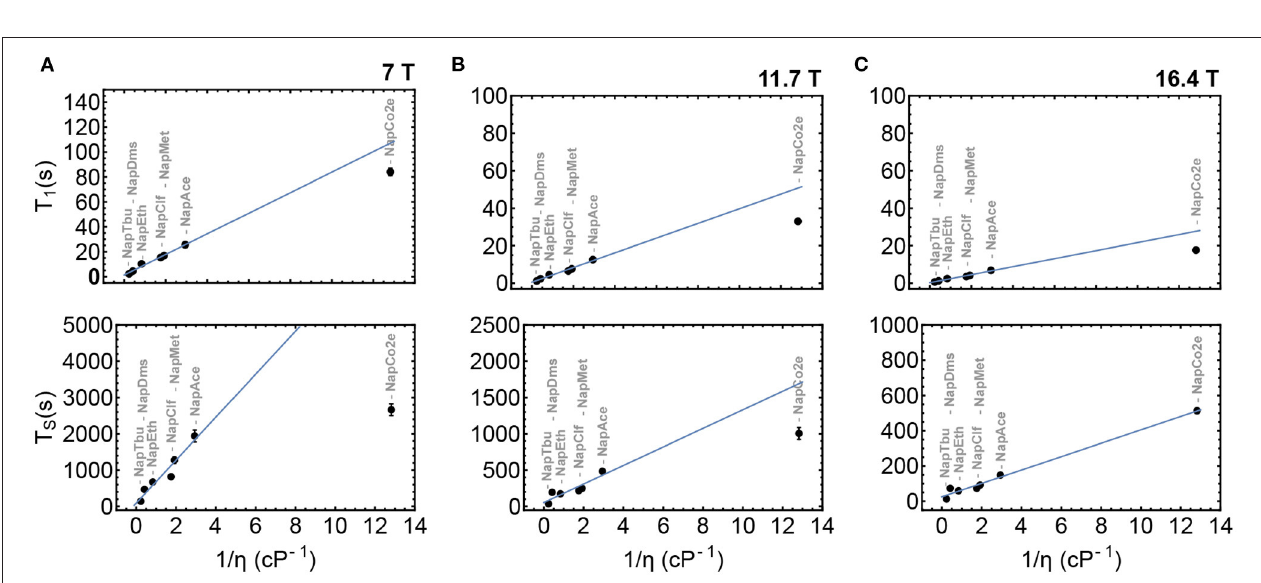
FIGURE 6 | T 1 and T S as a function of inverse viscosity in samples NapTbu - NapCo2e at 7, 11.7 and 16.4 Tesla fields in columns (A–C) , respectively. The blue line is the best fit to values for samples NapTbu - NapAce .